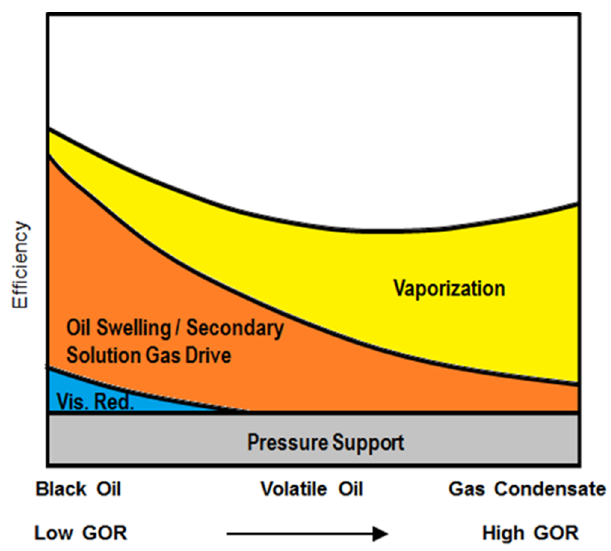
Figure 17. Summary of results for recovery mechanisms for huff-n-puff gas injection.